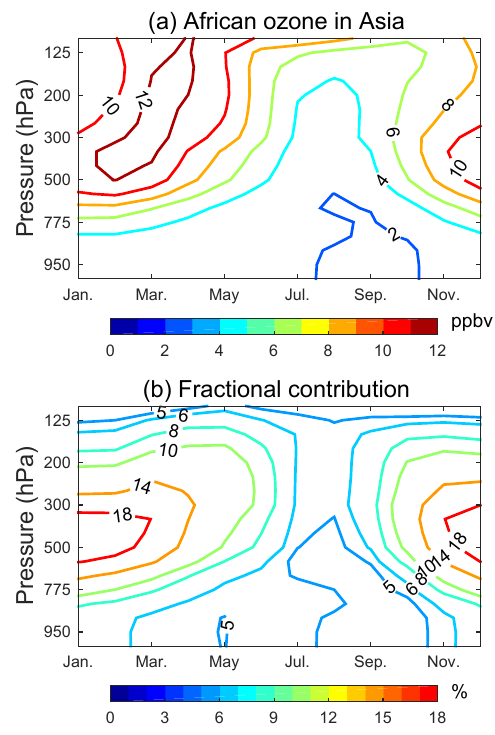
Figure 6. (a) Seasonal variation of imported African ozone (in ppbv) varying with altitude. (b) The same as (a) but for the cor- responding fractional contribution (in %). The values are the 20- year means (1987–2006) from the GEOS-Chem simulation aver- aged over Asia (60–145 ◦ E, 5–40 ◦ N; see Fig.